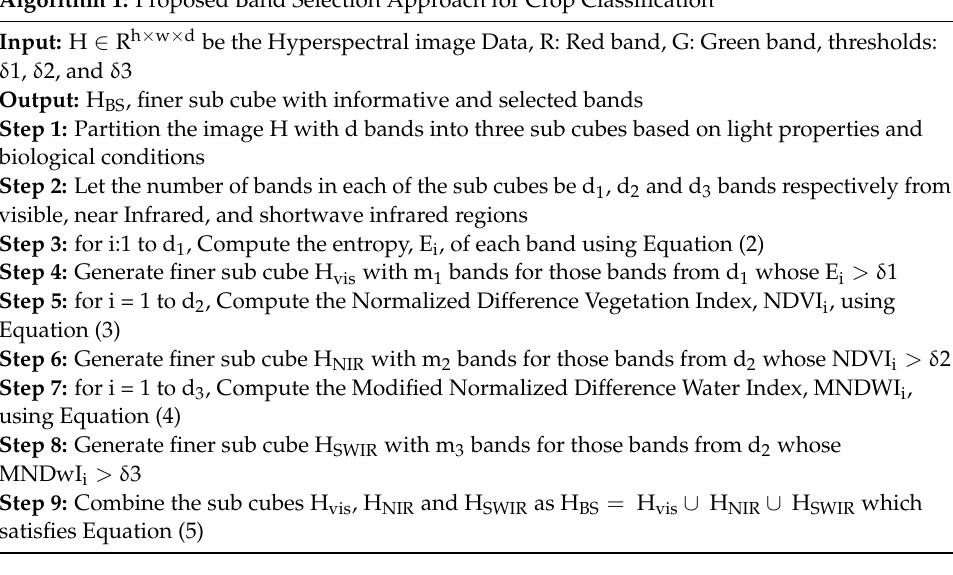
Algorithm 1: Proposed Band Selection Approach for Crop